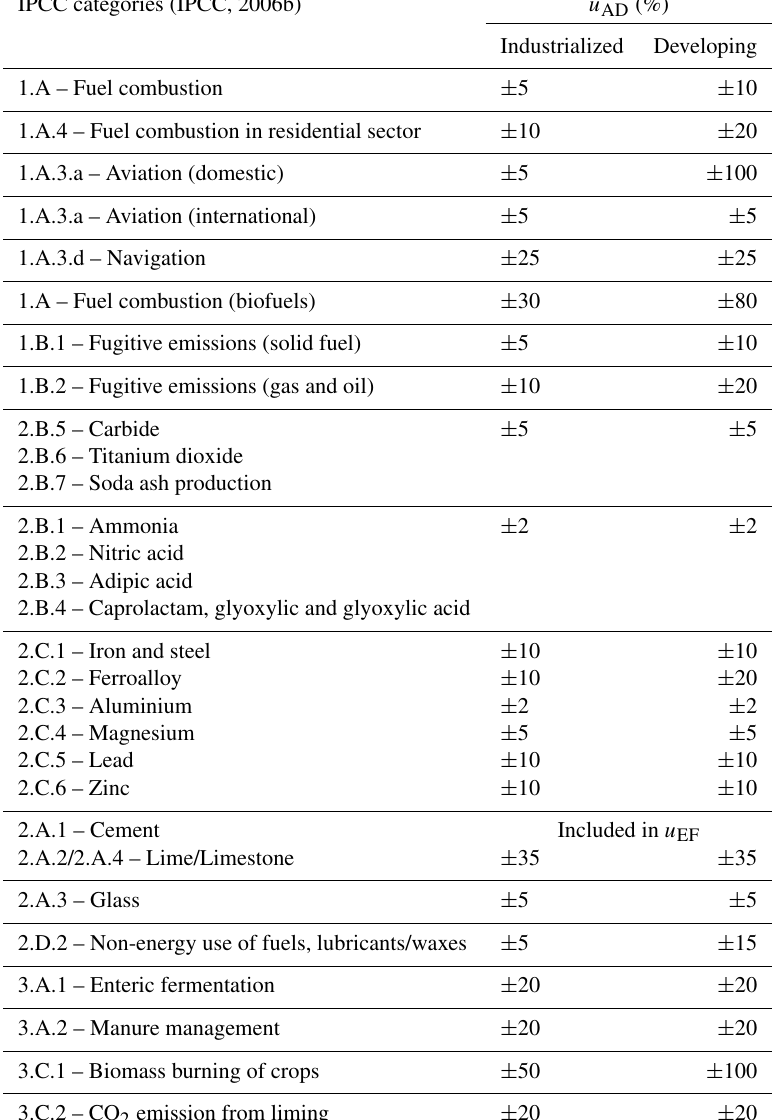
Table 1. Activity data (AD) statistical uncertainty (upper and lower limits define the 95% confidence intervals of a normal distribution). When two values are listed, the smaller range applies to industrialized countries, and the larger range applies to developing